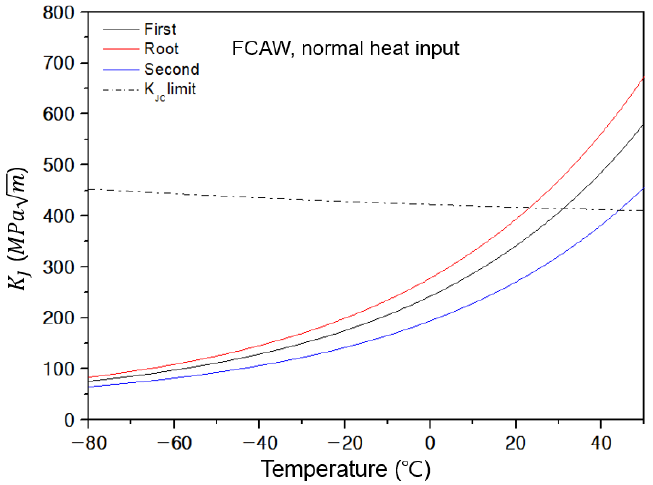
Figure 11. Master curve for FCAW, normal heat input condition according to sample location.